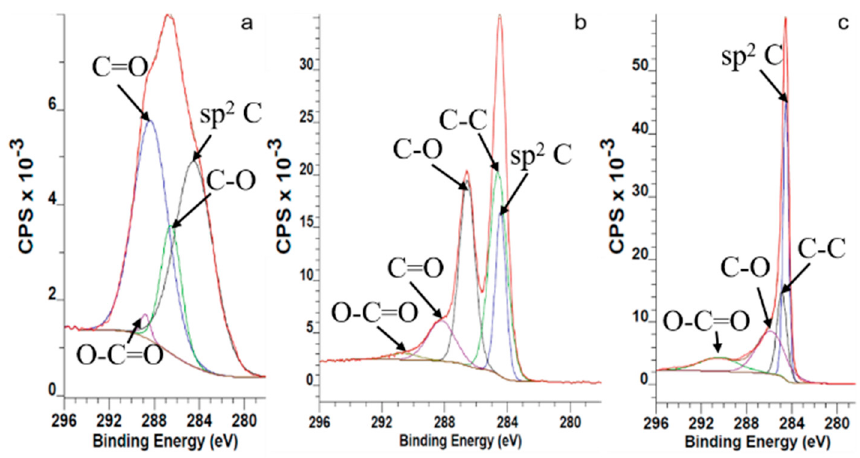
Figure 1. C1s XPS spectra of graphene oxide samples: ( a ) GO, ( b ) bwGO, ( c ) rGO and rbwGO.